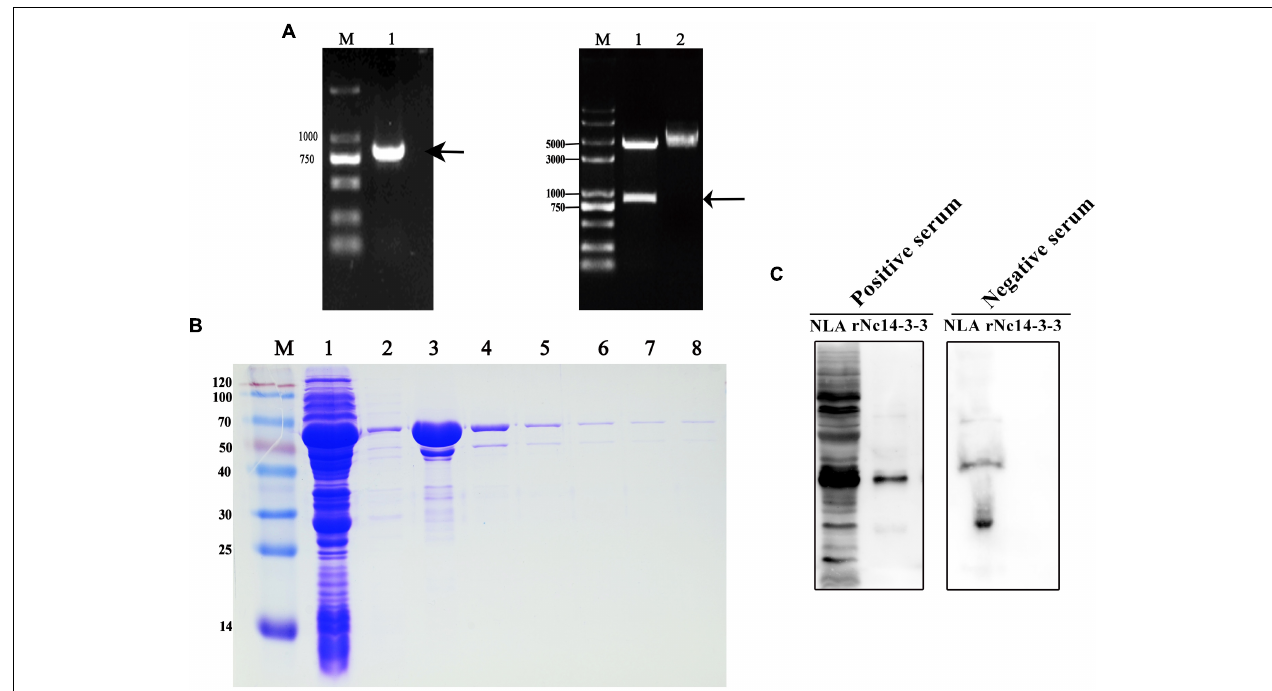
FIGURE 1 | Constructed plasmids and purified recombinant Nc14-3-3 protein. (A, Left) The Nc14-3-3 gene were amplified from cDNA using PCR. lane M: DNA Mark, lane 1: an 801-bp PCR product, arrow: an 801-bp PCR product that corresponded to Nc14-3-3. (Right) The product was cloned into the vector pGEX4T-1 and identified through restriction enzyme analysis. lane M: DNA Mark, lane 1: the pGEX-4T-1-Nc14-3-3 vector was confirmed by digestion with EcoRI and BamHI , lane 2: the pGEX-4T-1-Nc14-3-3 vector without digestion. (B) rNc14-3-3 purified using the Proteinlso GST Resin. M, protein molecular markers. Lanes 1–2, SDS-PAGE analysis of effluent and washed liquid. Lanes 3–8, the eluted buffer. (C) Western blotting analyzed of Neospora caninum lysate antigen (NLA) and rNc14-3-3 using anti- N. caninum serum (1:200). positive serum from mouse infected with N. caninum ; negative serum from healthy mouse.